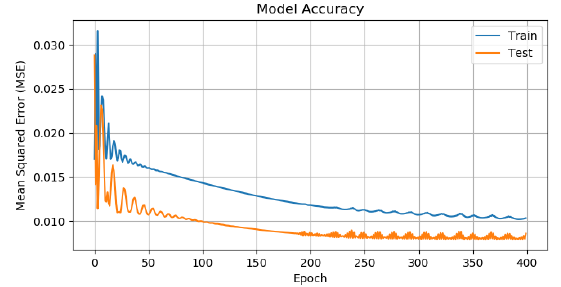
Figure 8. MLP precision